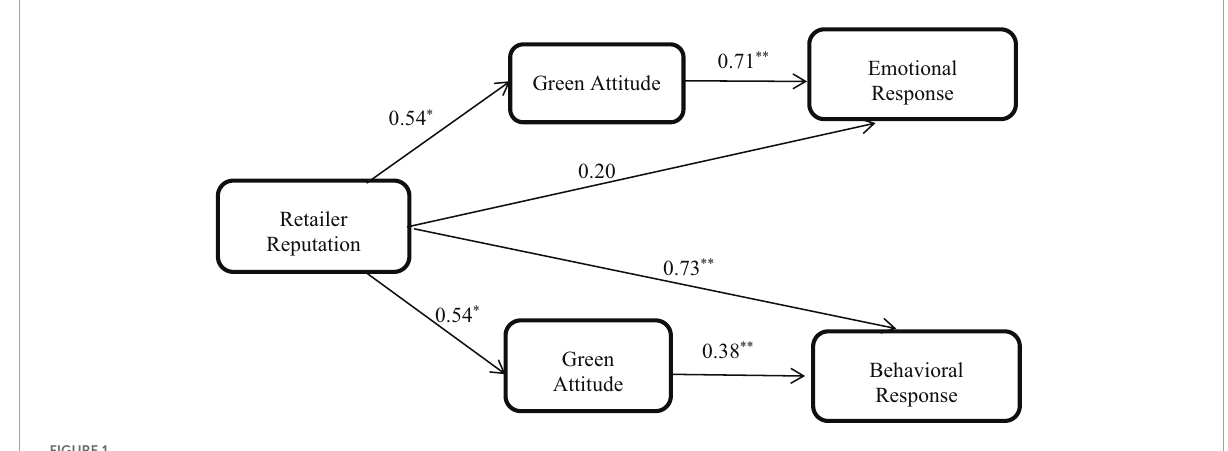
FIGURE1 Mediated model for green products with low involvement. ∗ p < 0.05, ∗∗ p < 0.01.